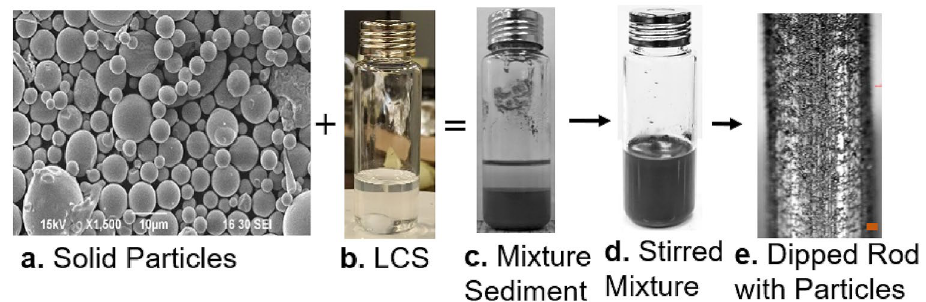
Figure 1. SEM micrographs of particles added to the homogeneous LCS to make the heterogeneous mixture. The mixture is stirred, and the rod is dipped for particle